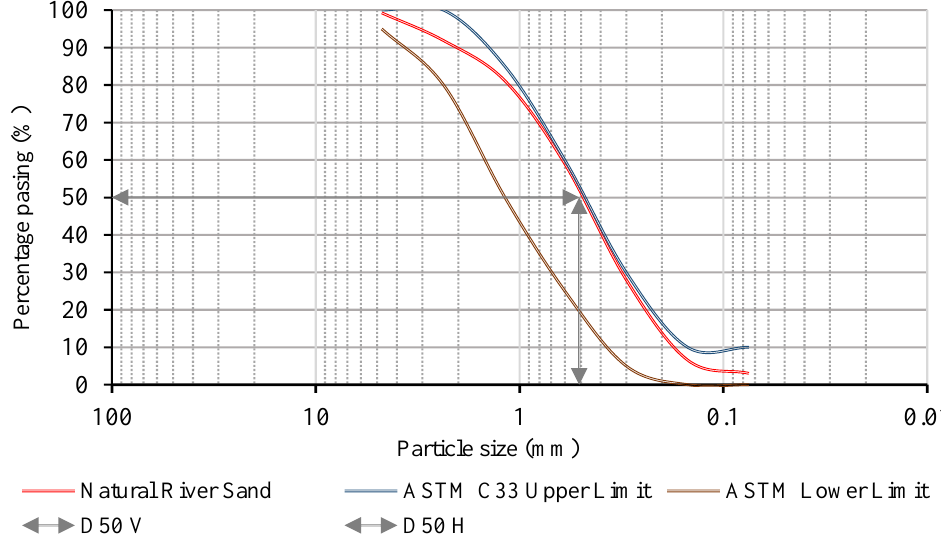
Figure 5. Natural river sand particle size distribution. Table 3 . Material properties of fly ash (FA), GGBS, and natural river sand.